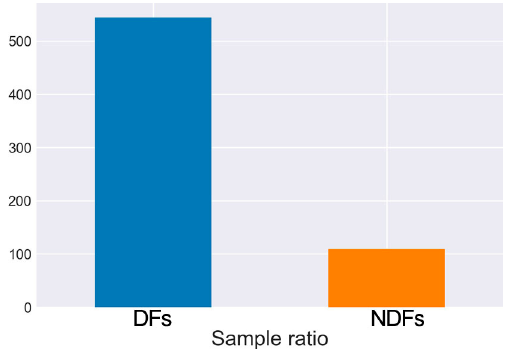
Figure 6. Sample ratio for DFs and NDFs.